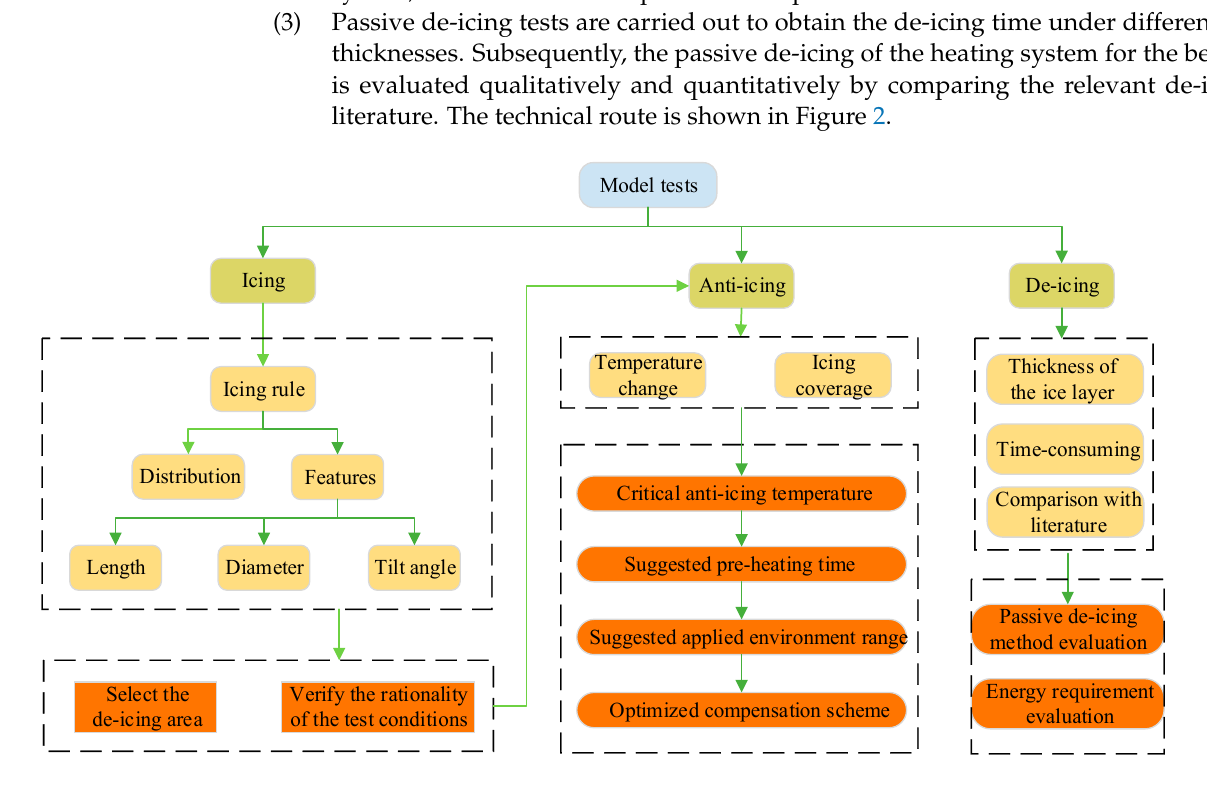
Figure 2. Technical route.